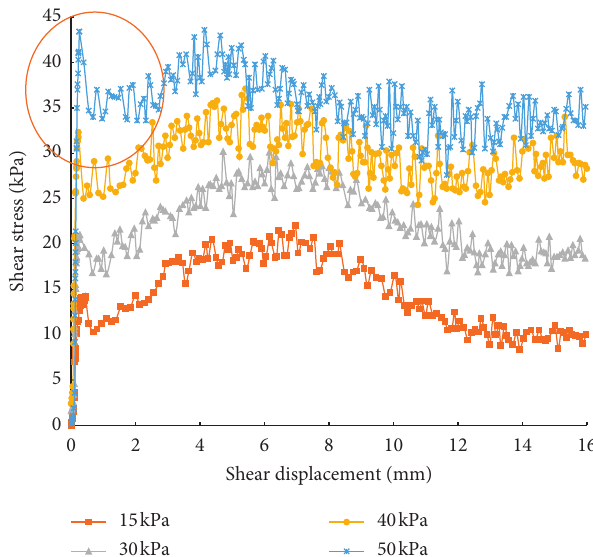
Figure 13: Shear stress-shear displacement curve of 0.8cm horizontal ring-shaped-reinforced sand.